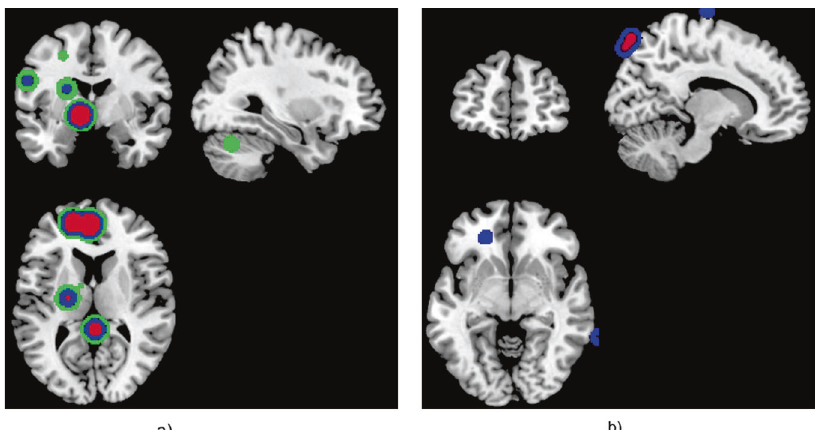
Fig. 3 Visualization of the relevance of the voxels in each class for the classi fi cation schema (a). We demonstrated the smoothed PR with a 7 × 7 × 7 Gaussian kernel of the correct classi fi ed subjects of each group against the other in classi fi cation schema (a), FEP vs. HC for the registered texture feature map: a difference of entropy and b contrast. The red (cluster 1), blue (cluster 2), and green (cluster 3) color corresponds to the sorted clusters according to the number of subjects belong to each cluster. gray levels, g 1 and g 2 [63]. We calculated feature maps only for cubes Table 1. Group comparison was investigated using one-way ANOVA including non-zero values, as presented in Appendix A. The registered for continuous and χ 2 test for categorical data. One-way ANOVA (Welch ’ s)